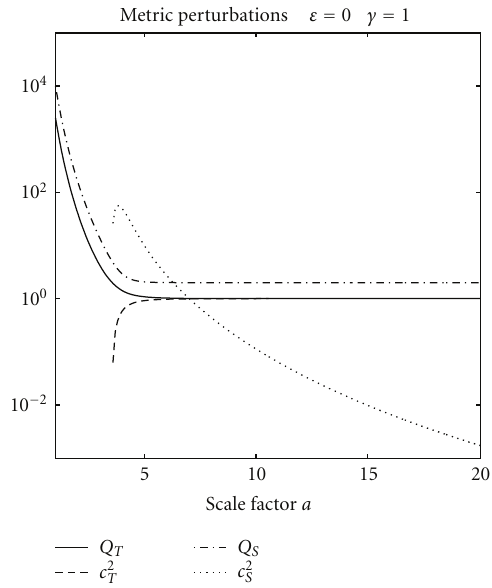
Figure 5: Evolution of the parameters for metric perturbations (scalar and tensorial parts), respectively, Q S , c 2 the text versus the scale factor, for γ = 1. As found theoretically, the initial high velocity of the field drives both the speed of (scalar and tensor) metric perturbations to imaginary values, thus signaling a breakdown of hyperbolicity for metric perturbations (here it happens when the corresponding curves terminate, since the y axis is in logarithmic scale).